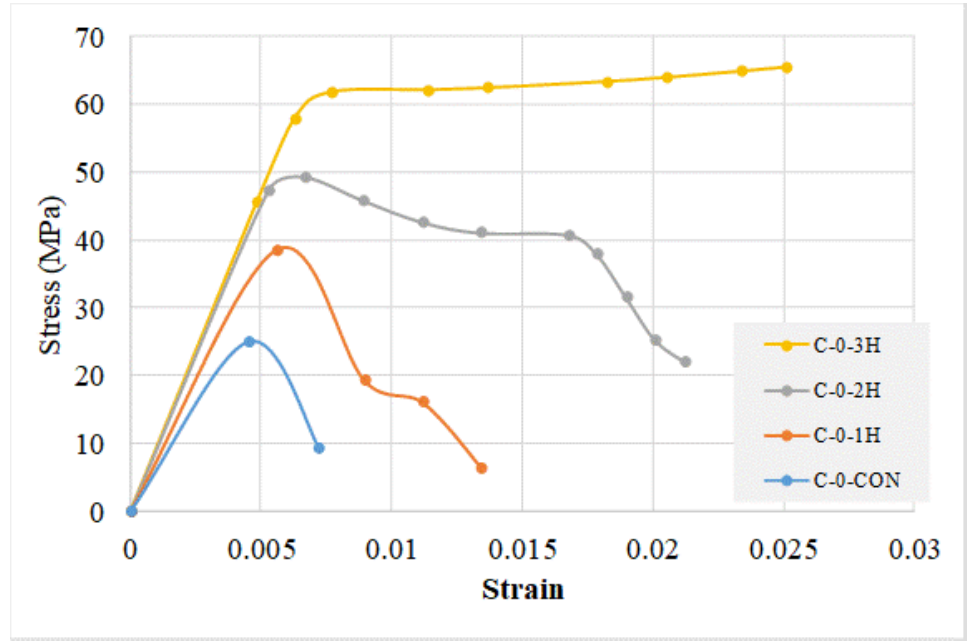
Figure 9. Compressive stress versus strain responses of Group 1 cylinders.